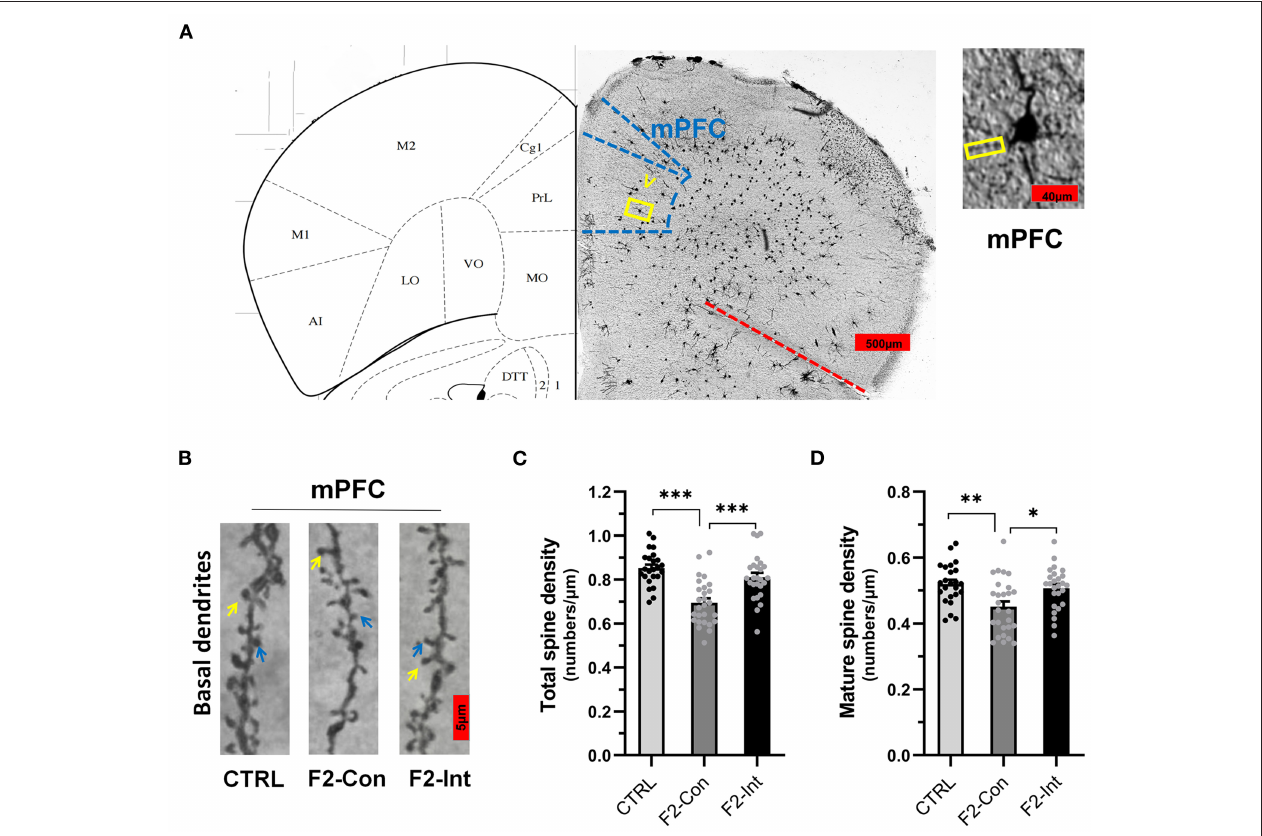
FIGURE 7 | Prenatal baclofen administration corrected the defects in dendritic spines density of pyramidal neurons in the mPFC in F2 mice. (A) A composite of a representative scanned image of Golgi-Cox-stained slices of the mPFC and the mouse brain map from The Mouse Brain in Stereotaxic Coordinates ; scale bar: 500 and 40 µ m. (B) The part inside the yellow rectangle is the neurons and dendrites selected from layer V in the mPFC for analysis. The spines were selected from grade 3 basal dendrites for analysis. The yellow arrow points to a mushroom spine, and the blue arrow points to a stubby spine. Scale bar: 5 µ m. (C,D) Summary of spine density on the basal dendrites of mPFC pyramidal neurons. Mature spines = mushroom spines + stubby spines (CTRL: n = 24 dendrites from 3 mice; F2-Con: n = 27 dendrites from 3 mice; F2-Int: n = 26 dendrites from 3 mice). One-way ANOVA followed by the Bonferroni post-hoc test was used to compare the differences among the four groups; * p < 0.05, ** p < 0.01, *** p < 0.001. All data for all figures are plotted as the mean ±